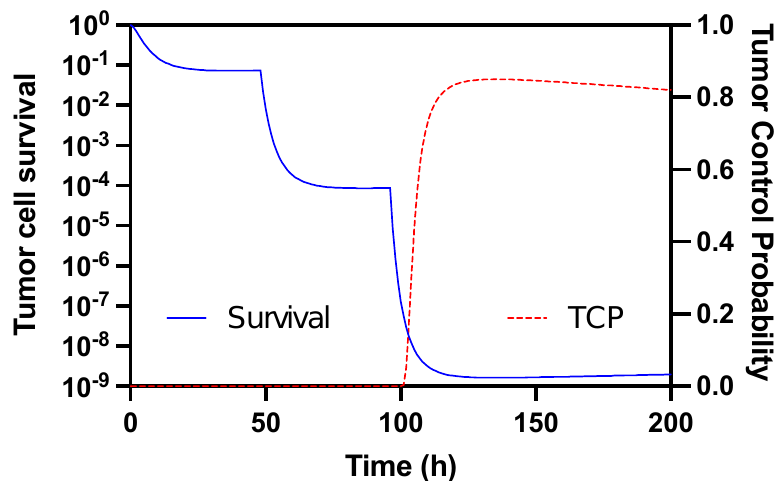
Figure 9. Prediction of SKOV-3 tumor cell survival and control probability after three cycles with 16 MBq 188 Re-ZHER2:41071 administered at two-day intervals, based on the dosimetry and tumor radiation sensitivity.